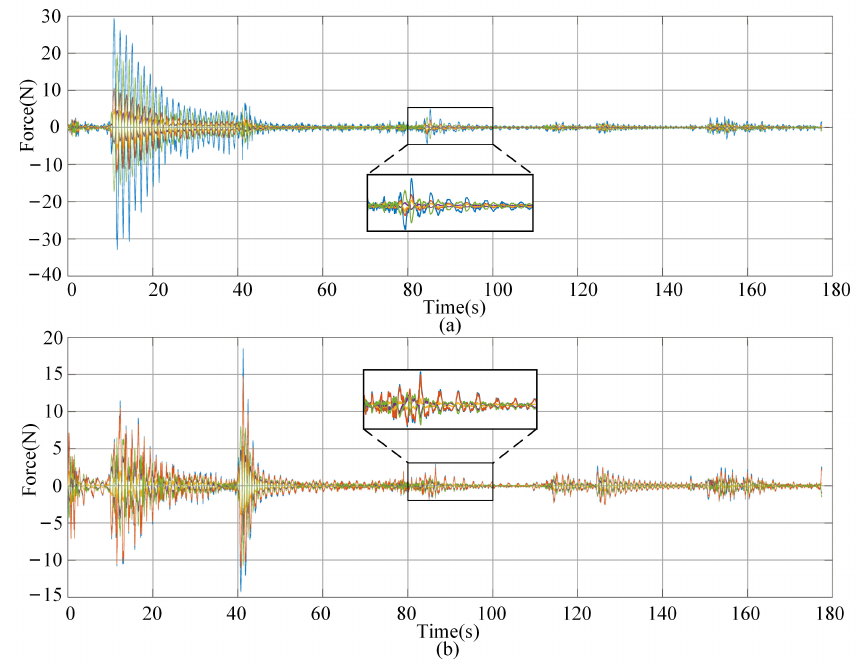
Figure 21. Tension curve of five linkage cables in the 5th segment. ( a ) Alpha direction. ( b ) Beta